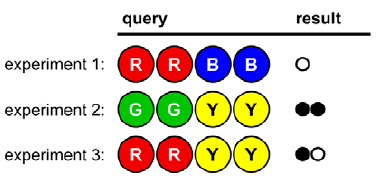
Figure 7. Opening strategy B, illustrating Lesson